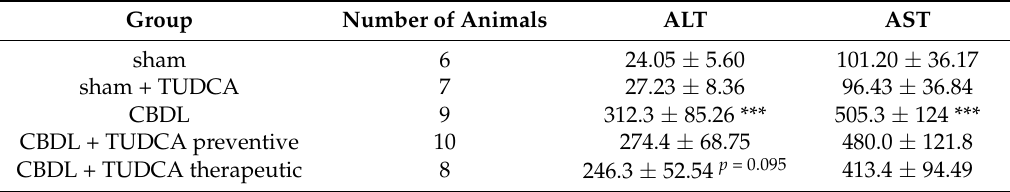
Table 1. ALT and AST levels.